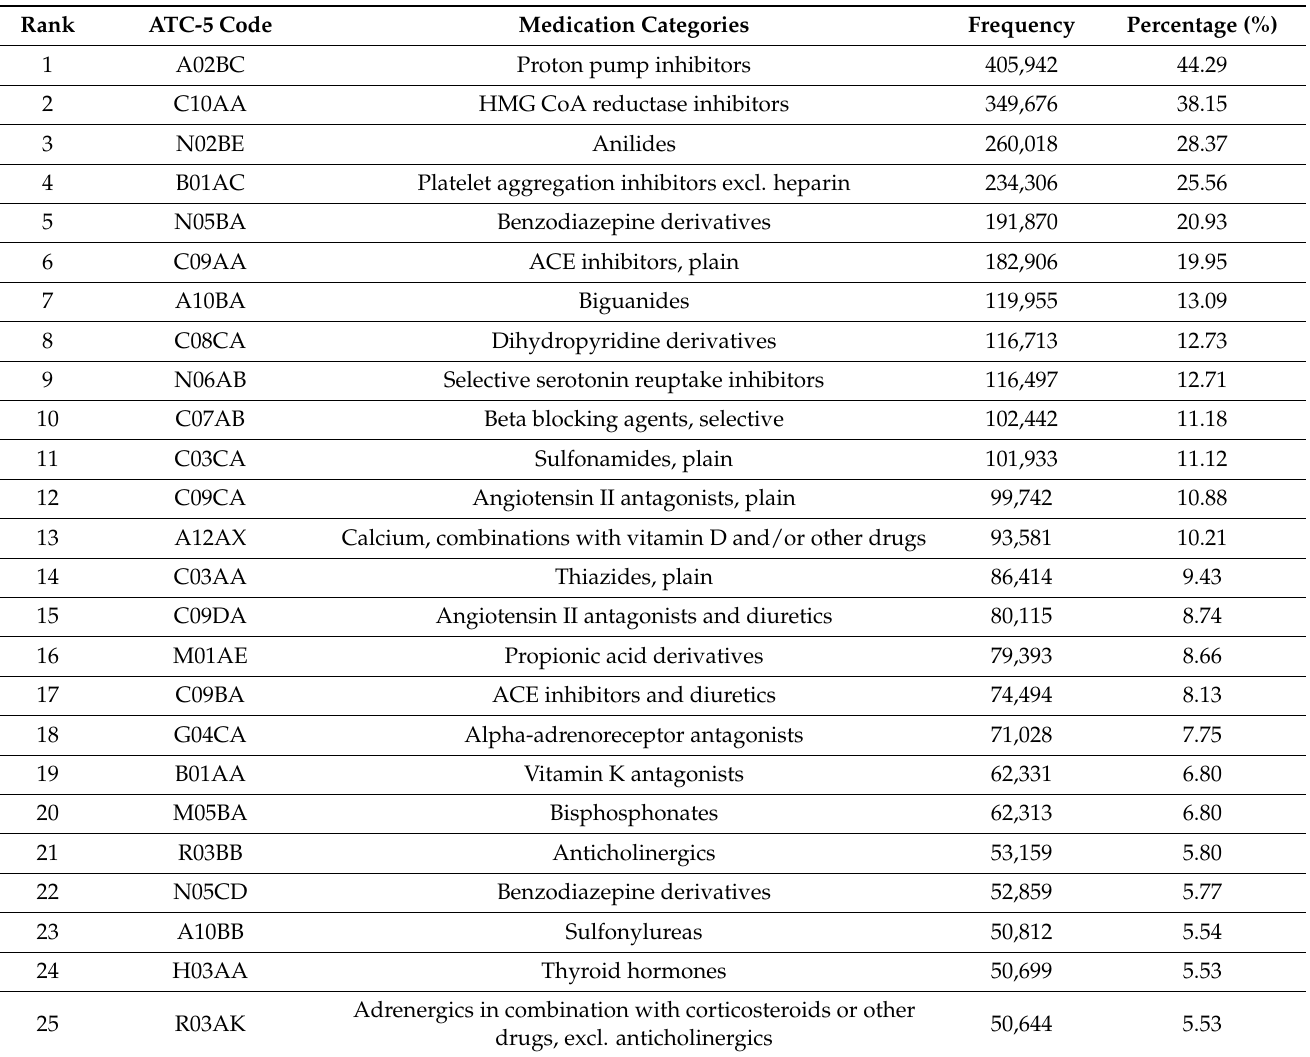
Table A2. Prevalence of the 89 medication categories diseases included in the study in individuals aged 65–99 years ( n = 916,619, Catalonia,